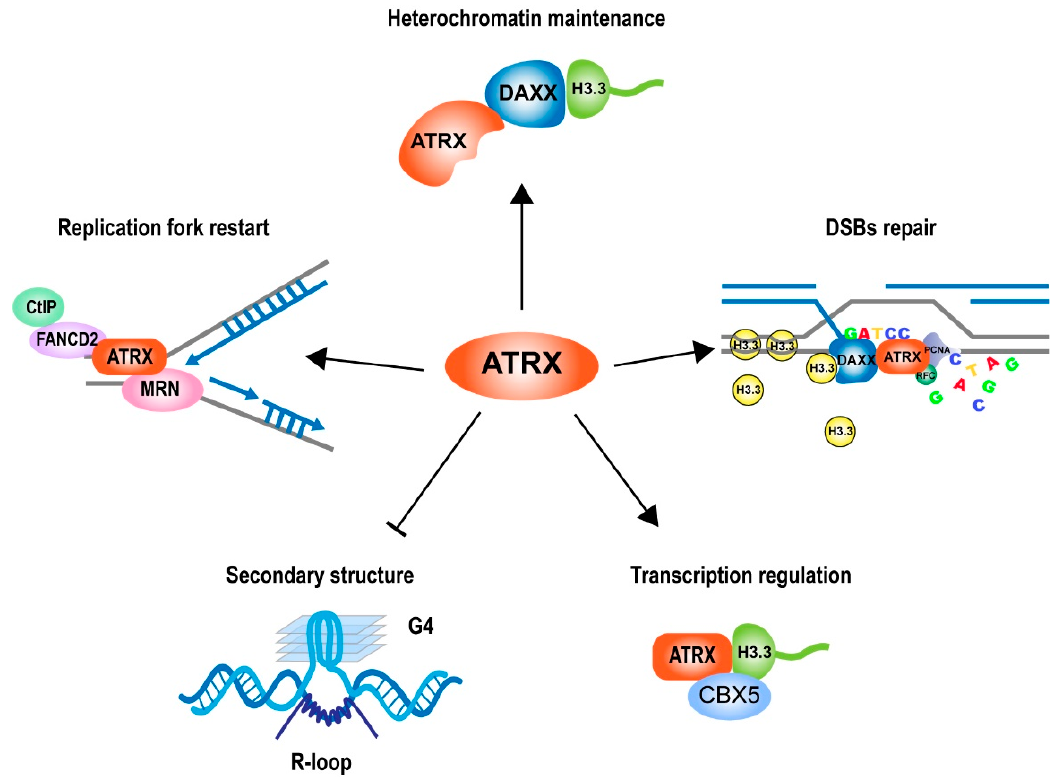
Figure 8. The multiple roles of ATRX in the cellular pathways. ATRX maintains the chromatin state at heterochromatic regions, responds to replication stress and promotes replication fork restart, promotes the DNA damage response (DDR), regulates transcription, and avoids G4 DNA